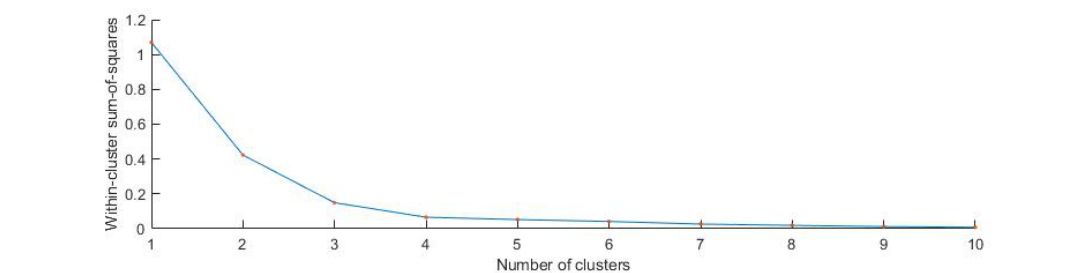
Figure 10. The graph of the elbow method applied to hierarchical